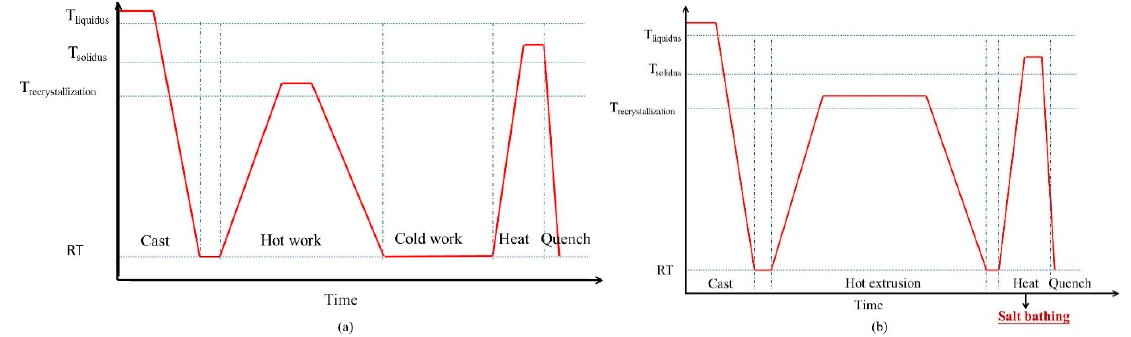
Figure 1. Procedures of ( a ) traditional three ‐ step strain ‐ induced melt activation (SIMA) process and ( b ) modified two ‐ step SIMA process. RT: room temperature.